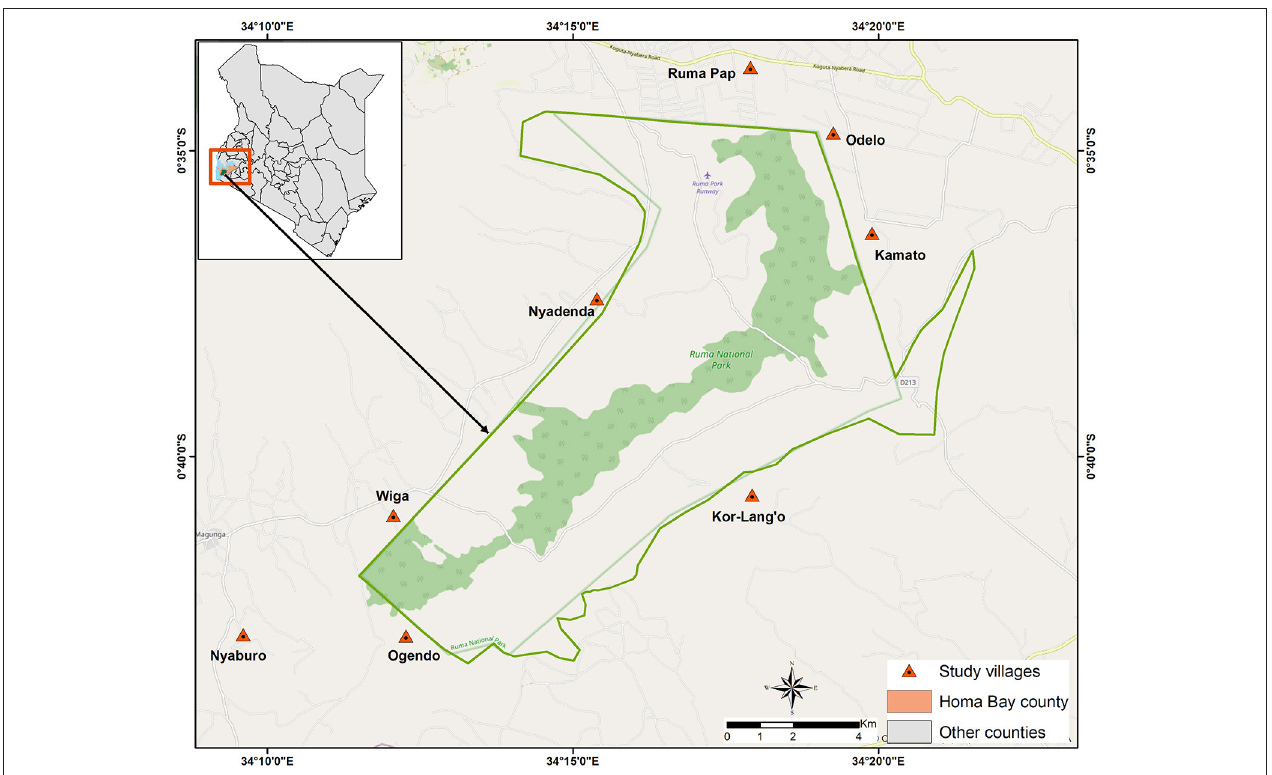
FIGURE 1 | Map of the study area indicating villages where cattle were